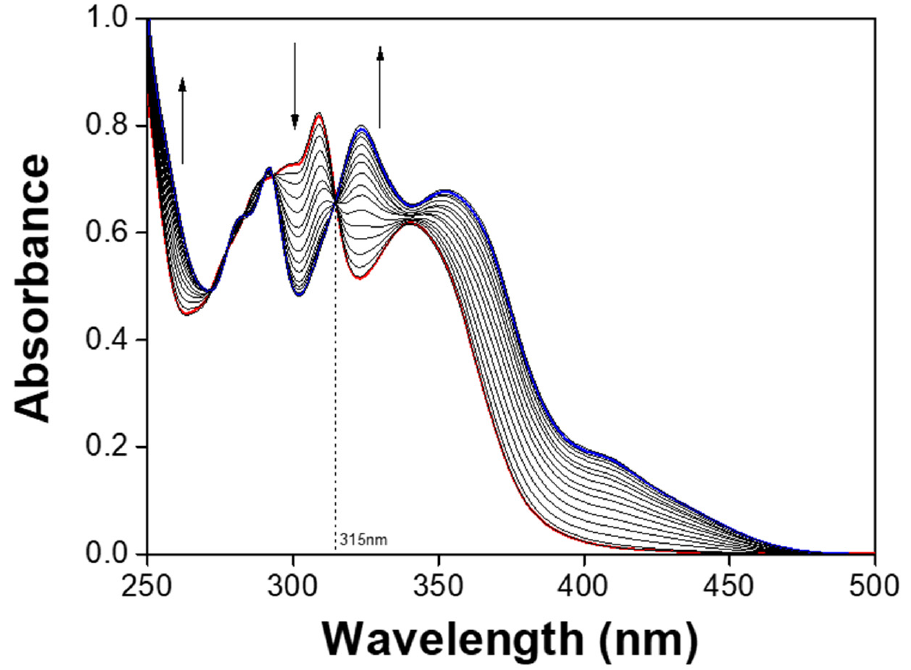
Figure 3. UV–Vis changes of NATB (30 μ M) with varied amounts of Al 3+ (0–1.5 equiv) in MeOH.